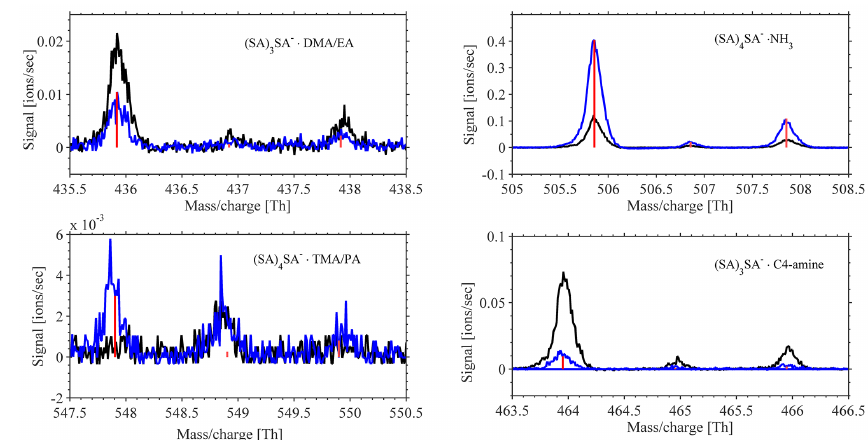
Figure 9. Examples of signals representing ambient measurement (blue) and zero (black) measurement. Zero gas (cryo N 2 ) contains more gas phase DMA/EA and a C4-amine (e.g. DEA) than ambient air. Only ammonia and potentially trimethyl/propyl amine (TMA/PA) signals exceed the signals from zero gas measurement. Red bars show the exact masses of isotopes and expected isotopic distribution normalized to the height of the main